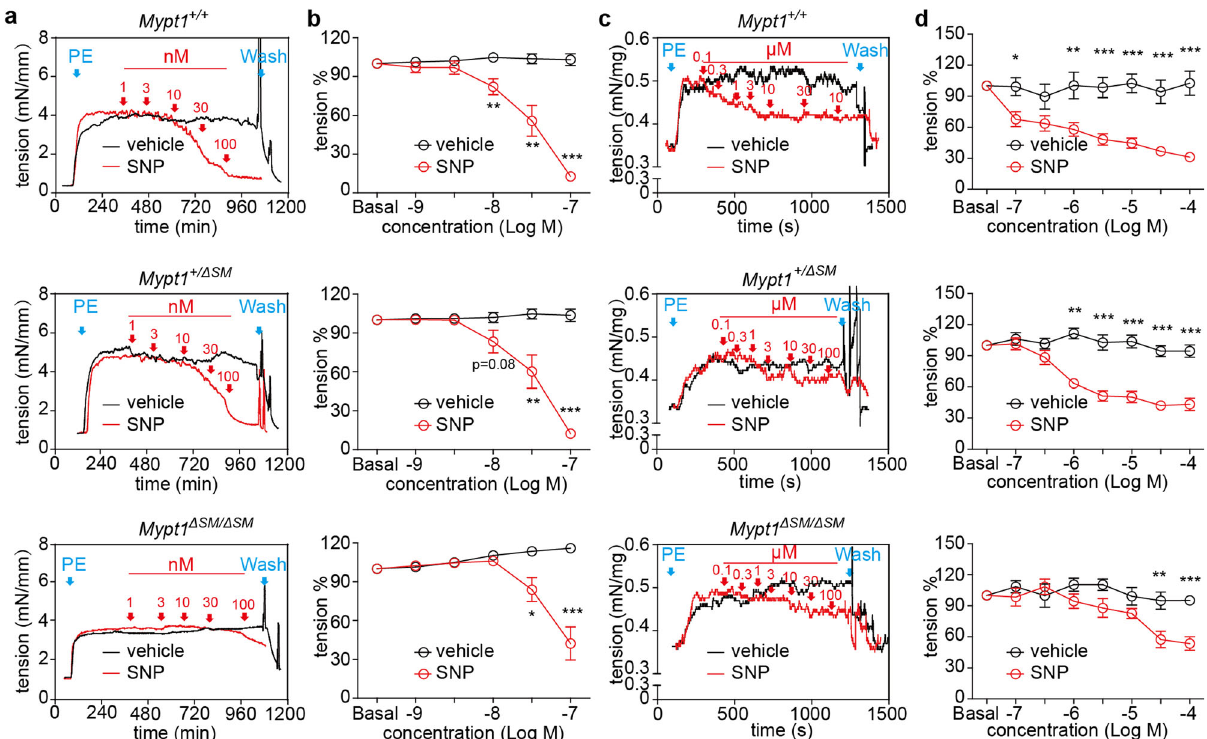
Fig. 4 Relaxant effects of SNP on PE-evoked contraction of MYPT1-de fi cient dorsal arteries and CCs. a and c , Representative force tracings of dorsal arteries ( a ) or CCs ( c ) precontracted with 10 μ M PE and then exposed to SNP (1 nM to 100 nM). b and d , Quanti fi cation of the relative ratios of force relaxation by the reagents (Panel b : n = 6; Panel d : n = 10). The relative ratio of the tension was calculated by the following formula: tension % = (F vehicle – F inhibitor )/F vehicle , F = force. The bars indicate the mean values ± SEM; * p < 0.05, ** p < 0.01, *** p < 0.001; pair t-